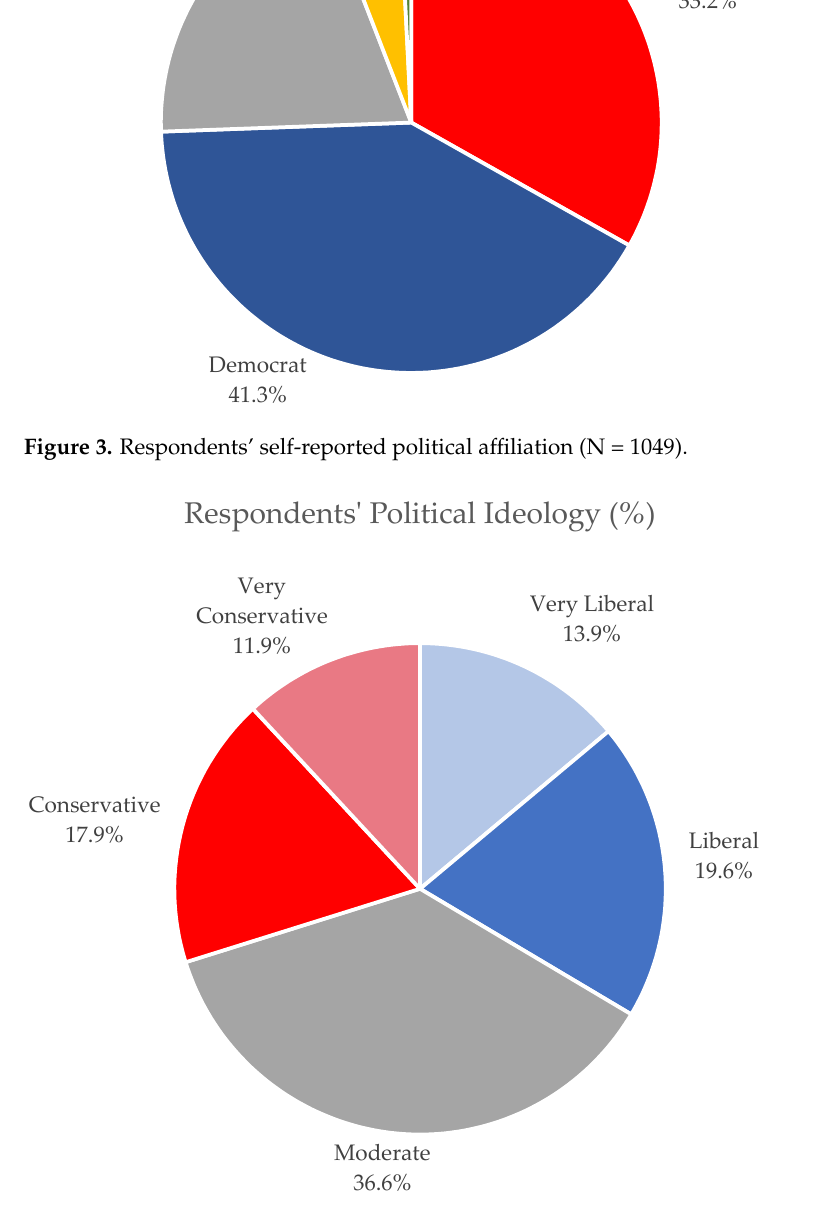
Figure 4. Respondents’ self-reported political ideology (N = 1049).